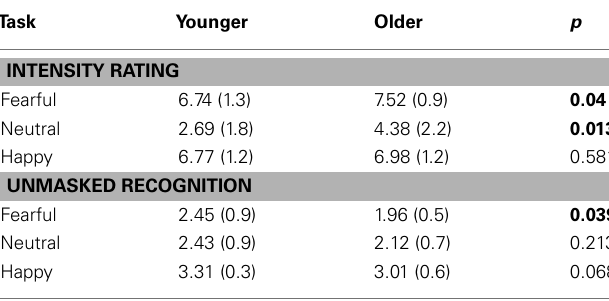
fearful ( M oldfear = 1.98, SE oldfear = 0.11) than for neutral faces Table 1 | Mean (and SDs) intensity ratings and mean d (cid:48) (and SDs) in the unmasked